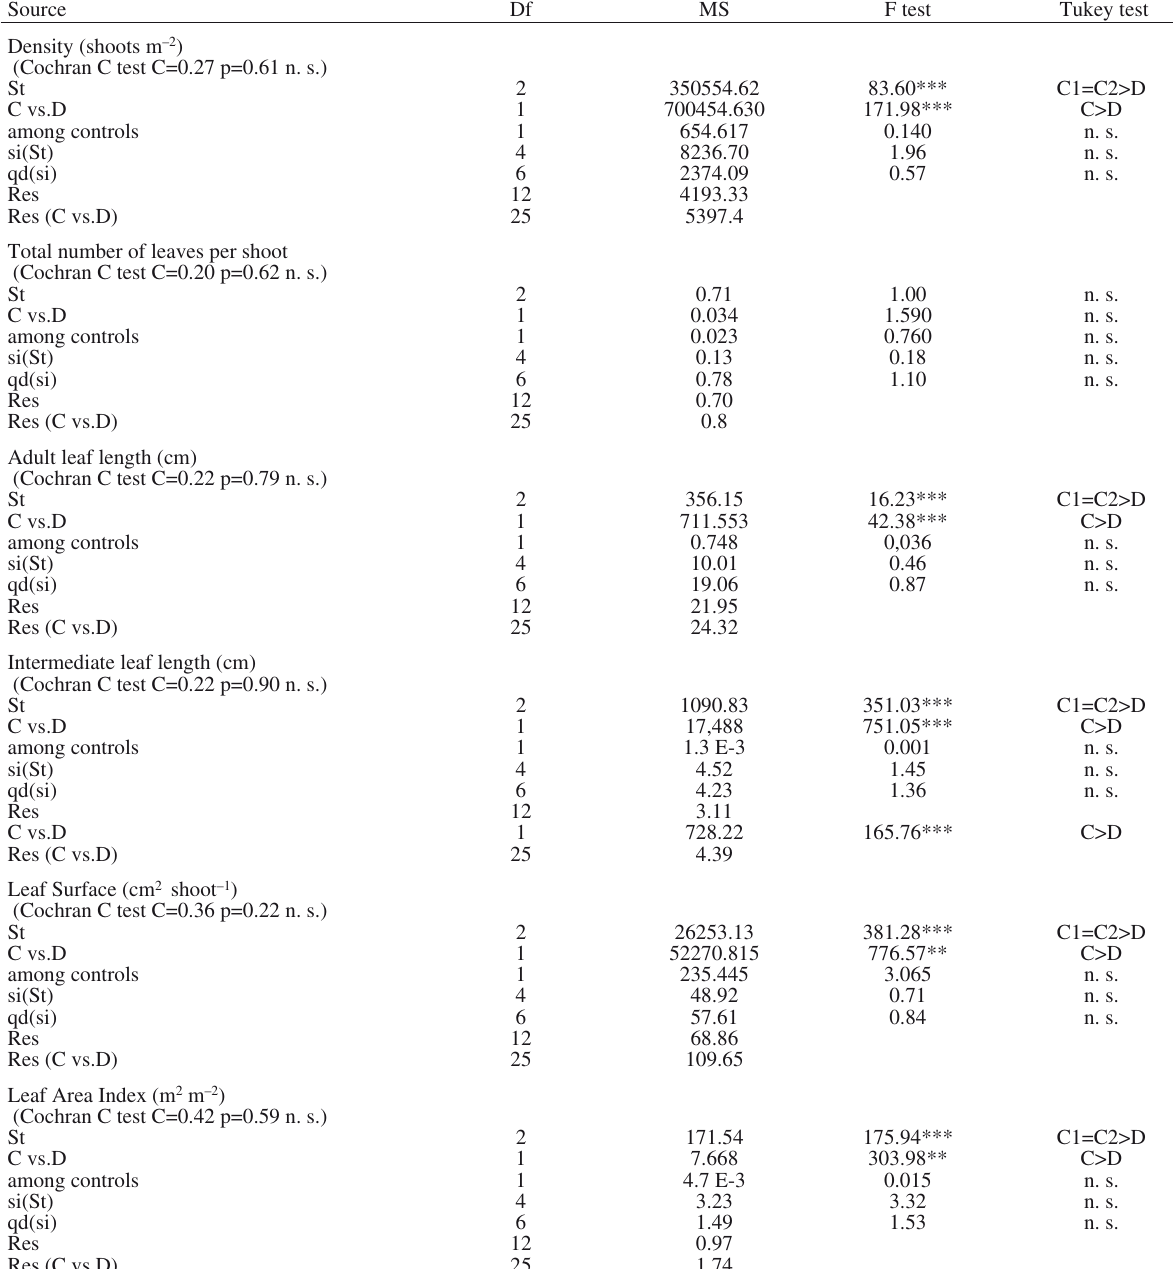
Table 2. – ANOVA on phenological parameters of P. oceanica between controls and the disturbed station. St, station; si, site; qd, quadrate; C, control; D, disturded; res, residuals; ** p<0.01; *** p<0.001 Source Df MS F test Tukey